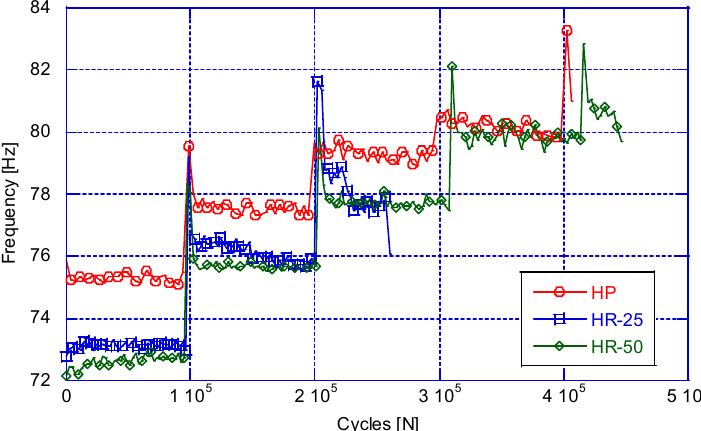
Figure 8. Resonance fatigue frequency evolution during a Locati test for OPC mixes.